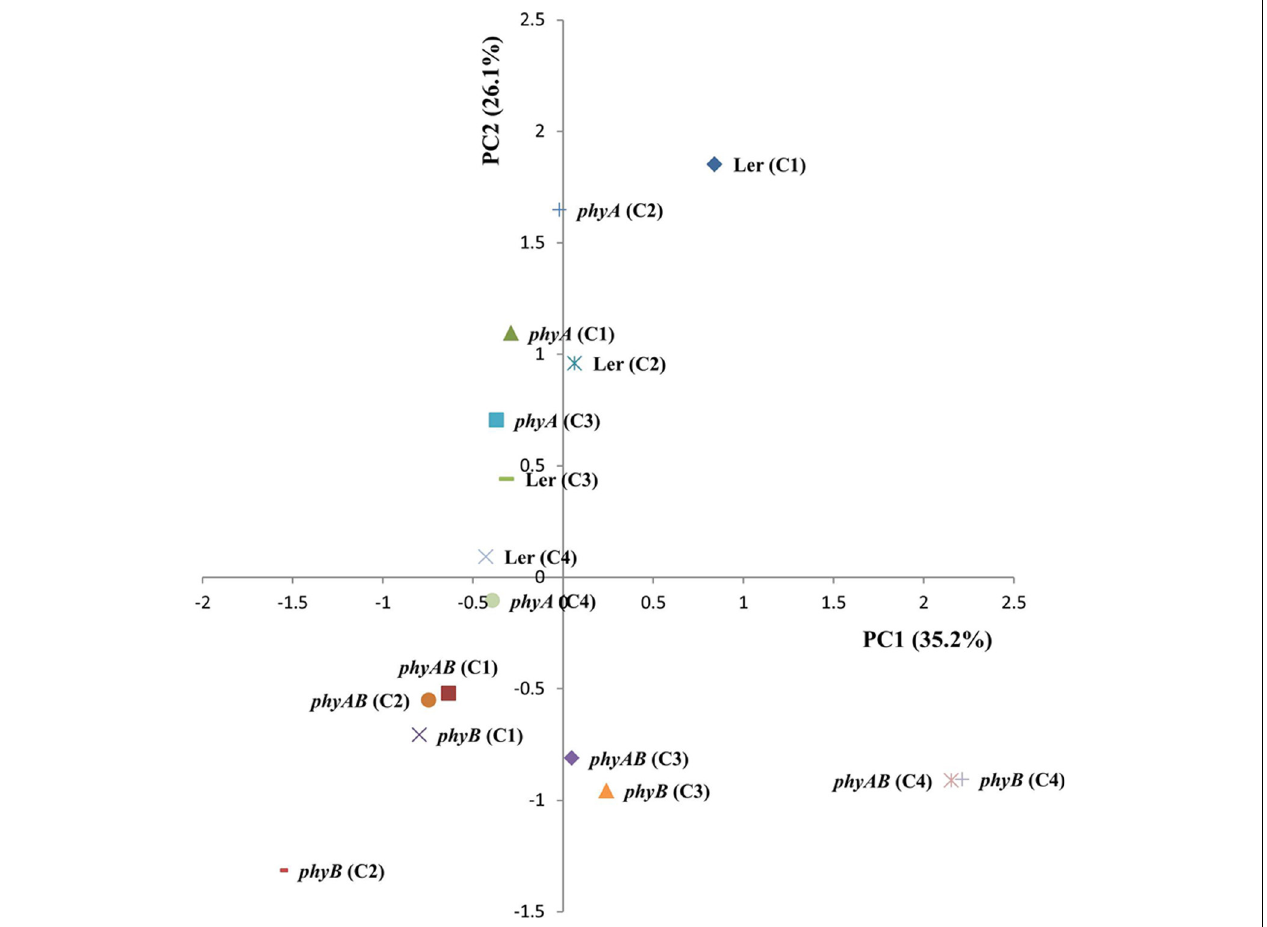
FIGURE 4 | Leaf metabolome analysis of WT and the phyA , phyB, and phyAB mutants using PCA. Plants were grown in four different white light conditions and sampled at